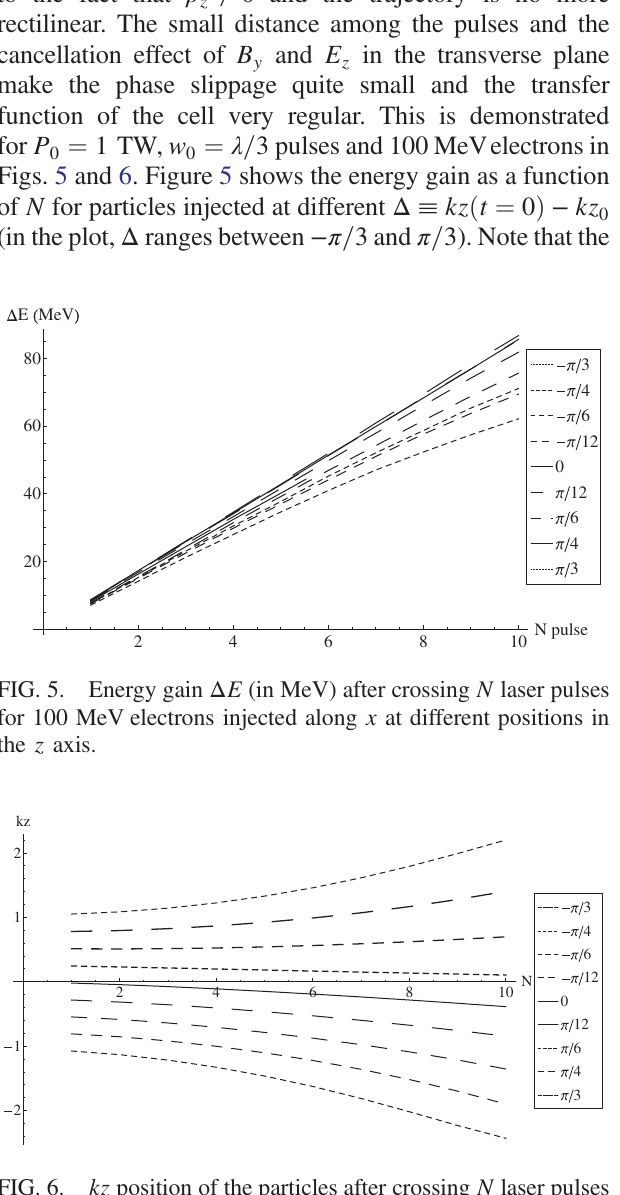
FIG. 6. kz position of the particles after crossing N laser pulses for 100 MeV electrons injected along x at different positions in the z axis.